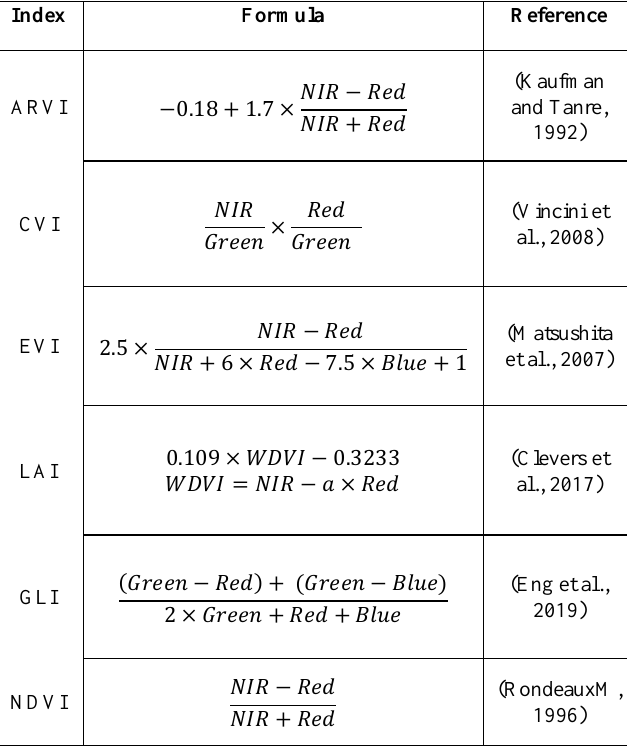
Table 2 . Vegetation indices derived from Sentinel-2